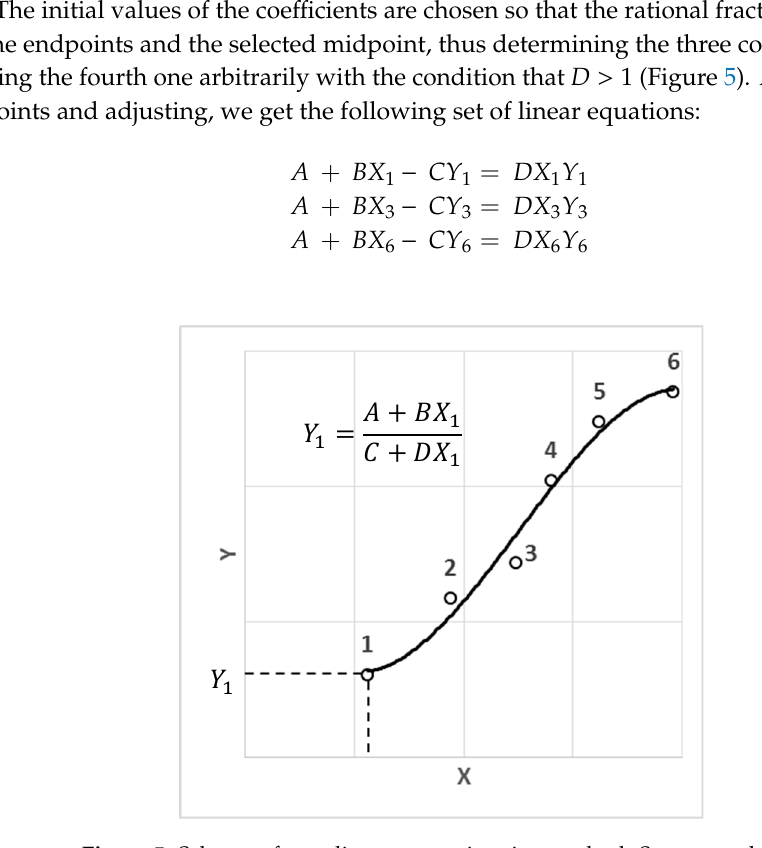
Figure 5. Scheme of coordinate approximation method. Source: authors.